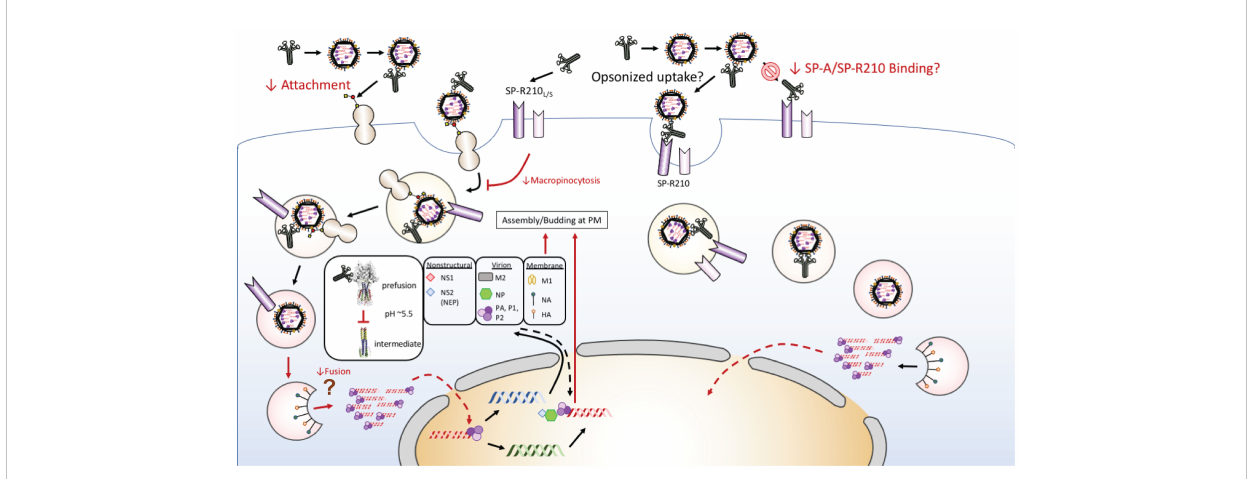
FIGURE 6 Proposed model of SP-A-IAV interaction in macrophages. Multi-site inhibition of IAV infection of macrophages occurs through indirect inhibition of macropinocytic entry, delayed sorting to acidi fi ed endosomes or steric hindrance of endosomal fusion of HA, and reciprocal inhibition of cognate receptor binding. A direct mechanism by the SP-A receptor SP-R210 may mediate endocytic entry and result in permissive infection that may be deployed by different strains of IAV along a gradient of SP-A levels and oligomeric forms towards the lower respiratory tract and over the course of